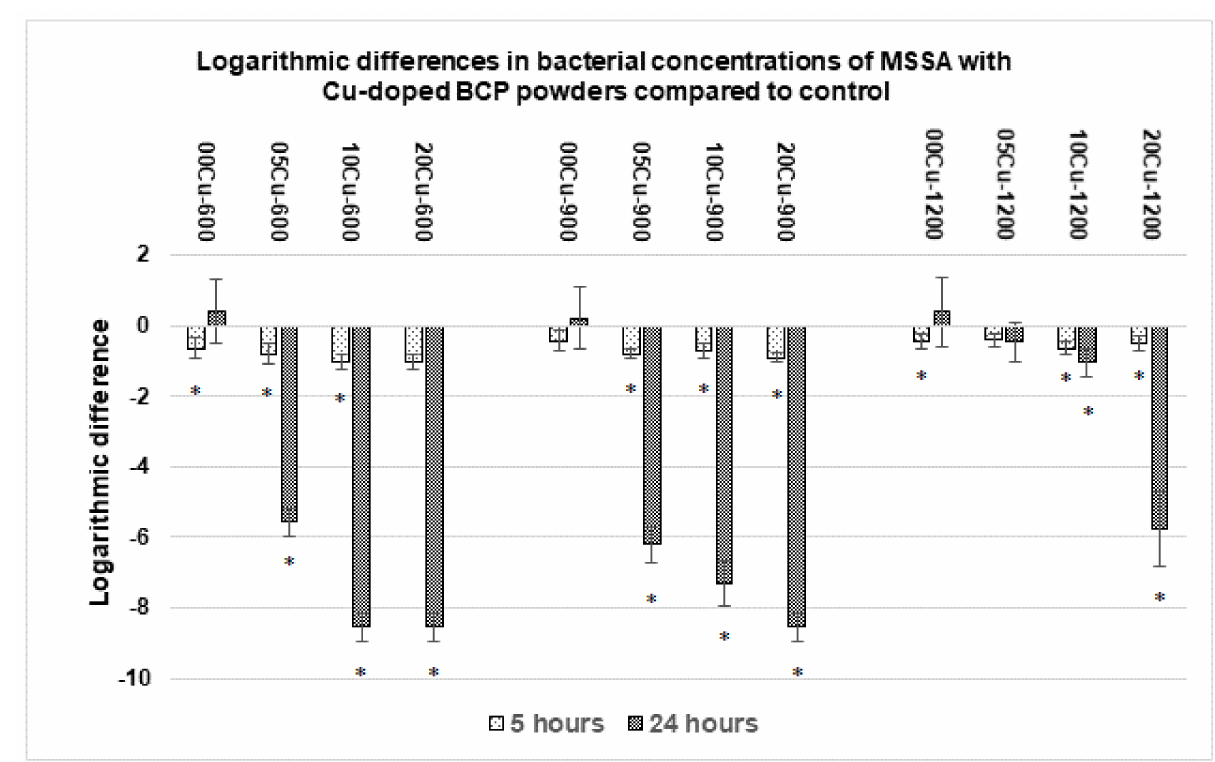
Figure 3. Concentrations of viable MSSA after incubation with Cu-doped BCP powders compared to the control at 5 h and 24 h. Results statistically different compared to the control (with p < 0.05) are indicated by